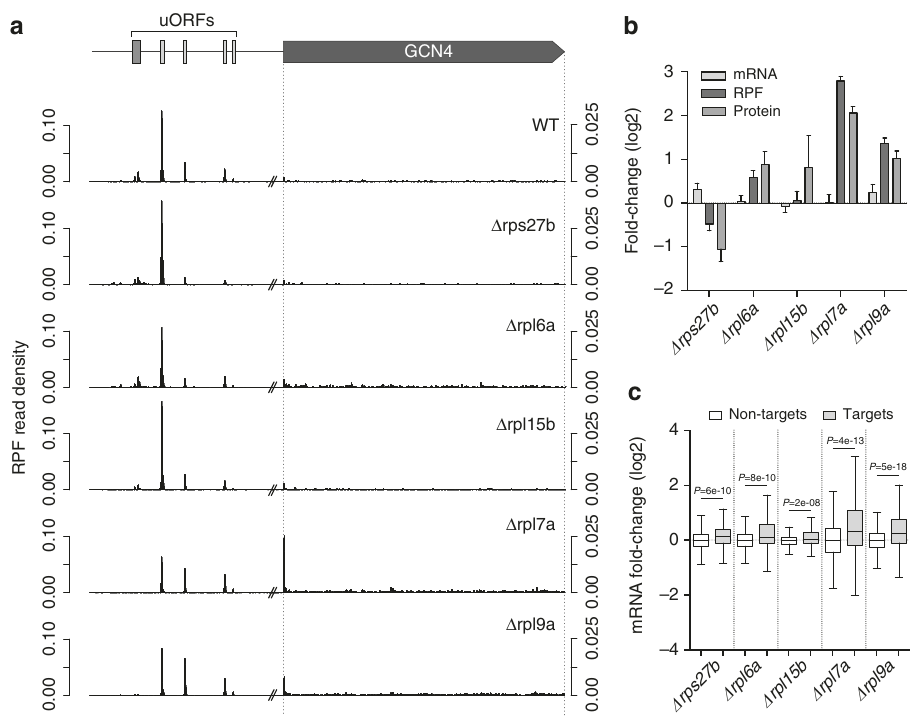
Fig. 4 GCN4 is translationally upregulated in long-lived RPKO strains. a Density of ribosome protected fragment (RPF) reads along the GCN4 locus in the different strains studied. Long-lived strains show decreased density speci fi cally at non-canonical ( dark gray ) and subsequent, fi rst canonical uORF ( light gray ) as well as increased density in the main ORF, particularly at the start. Note the different scales upstream and within the coding regions. b Quanti fi cation of mRNA, ribosome-protected fragments and protein fold-changes for Gcn4 in the different RPKO strains with respect to the wild-type strain. Error bars indicate the s.e.m. c Boxplots show the mRNA fold-changes for Gcn4 targets ( gray , from http://www.yeastgenome.org) and non-targets ( white ) in the RPKO strains compared to wild-type strain. P -values were calculated using the two-sided Mann – Whitney U test. Boxes extend from the 25th to 75th percentiles (interquartile range (IQR)), horizontal lines represent the median, whiskers indicate the lowest and highest datum within 1.5*IQR from the lower and upper quartiles,